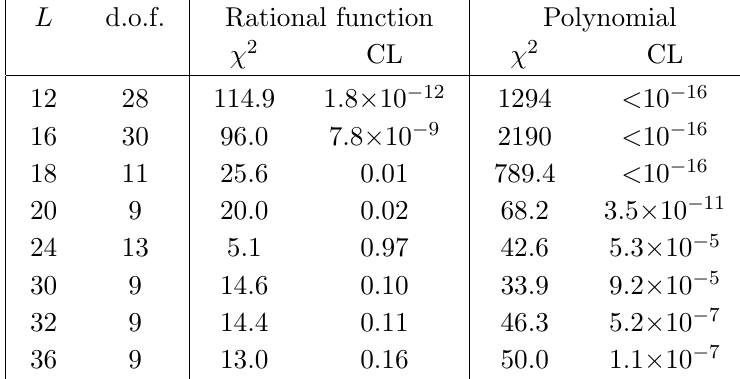
Table 23 . Quality of c = 0 : 2 renormalized coupling interpolations as functions of the bare coupling, g 2 ( (cid:12) F ) on each L 4 lattice volume. Both the rational function interpolations using eq. (4.1) and e c =0 : 2 the polynomial interpolations using eq. (4.2) use the clover discretization of E ( t ) with optimal (cid:28) opt = 0 : 08 and involve the same number of (cid:12)t parameters producing the same number of degrees of freedom. The con(cid:12)dence level (CL) is computed from the (cid:31) 2 and d.o.f. through eq. (C.1).